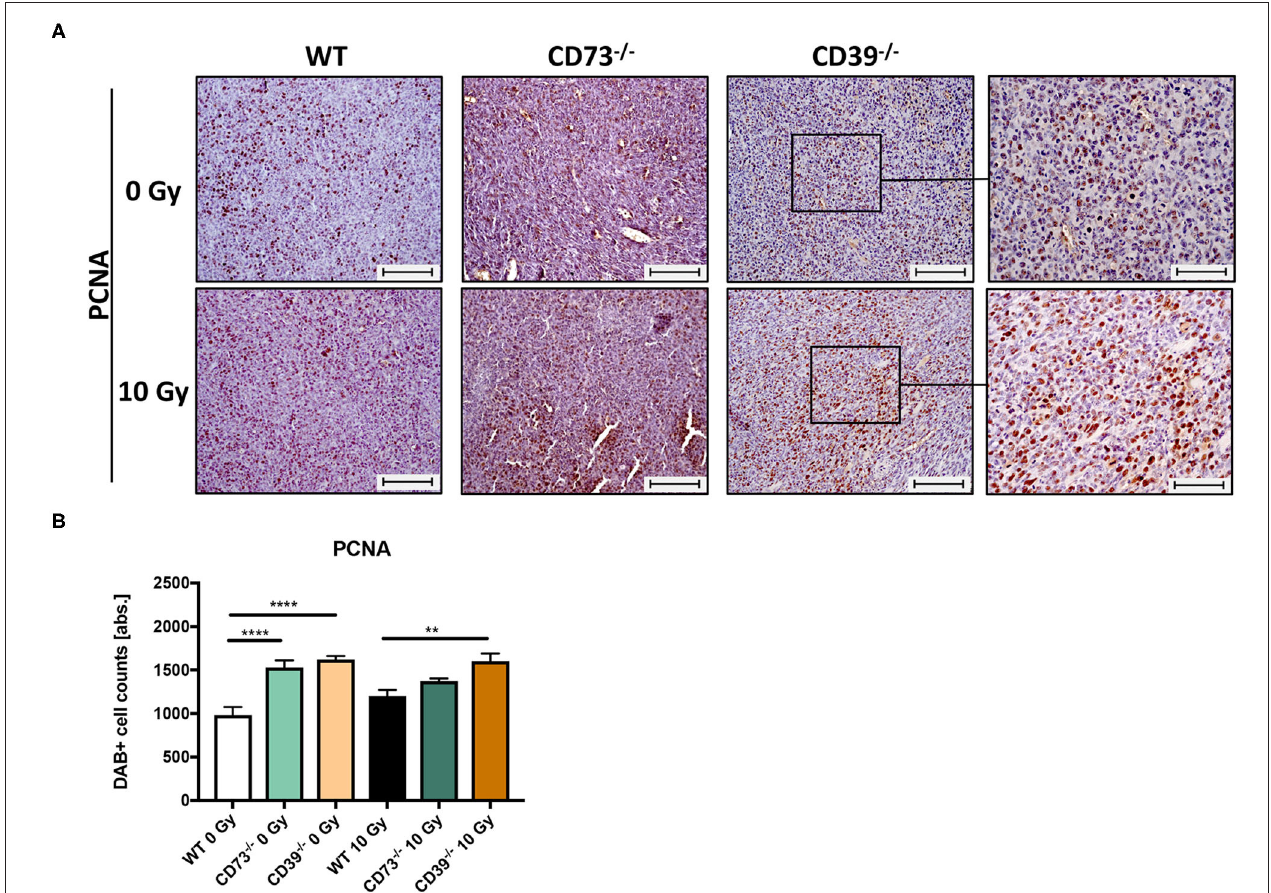
FIGURE 6 | LLC1 tumor grown on CD39 − / − mice are not impaired in their proliferative activity after irradiation. LLC1 tumor cells (0.5 × 10 6 cells each) were subcutaneously transplanted onto the hindlimb of C57BL/6 wild-type and CD39- and CD73-deficient [knockout ( − / − )] mice. Hind-leg single-dose irradiation with 0 or 10Gy was conducted at the timepoint of tumor manifestation. Mice were sacrificed at the timepoint of maximal tumor volume (1,000 mm 3 ). IHC staining of proliferation cell nuclear antigen (PCNA) of paraffin-embedded LLC1 tumor tissue, magnification 200-fold, scale bar 100 µ m (A) . Shown in bar diagrams are the absolute numbers of DAB + cell counts per tissue section (B) . Magnified pictures (400-fold) highlight special structures. Shown are means ± SEM, ** P ≤ 0.01, **** P ≤ 0.0001, analyzed by one-way ANOVA followed by a post hoc Tukey test n = 15/17 (C57BL/6), n = 17/13 (CD39 − / − ), n = 7/13 (CD73 − / − ).